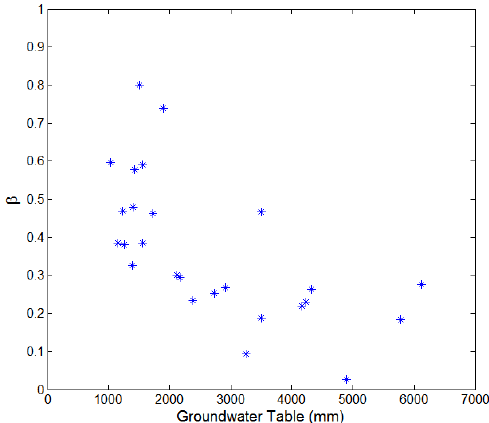
Fig. 11. The relationship between estimated β and observed shallow groundwater table depth at the Spoon River watershed.